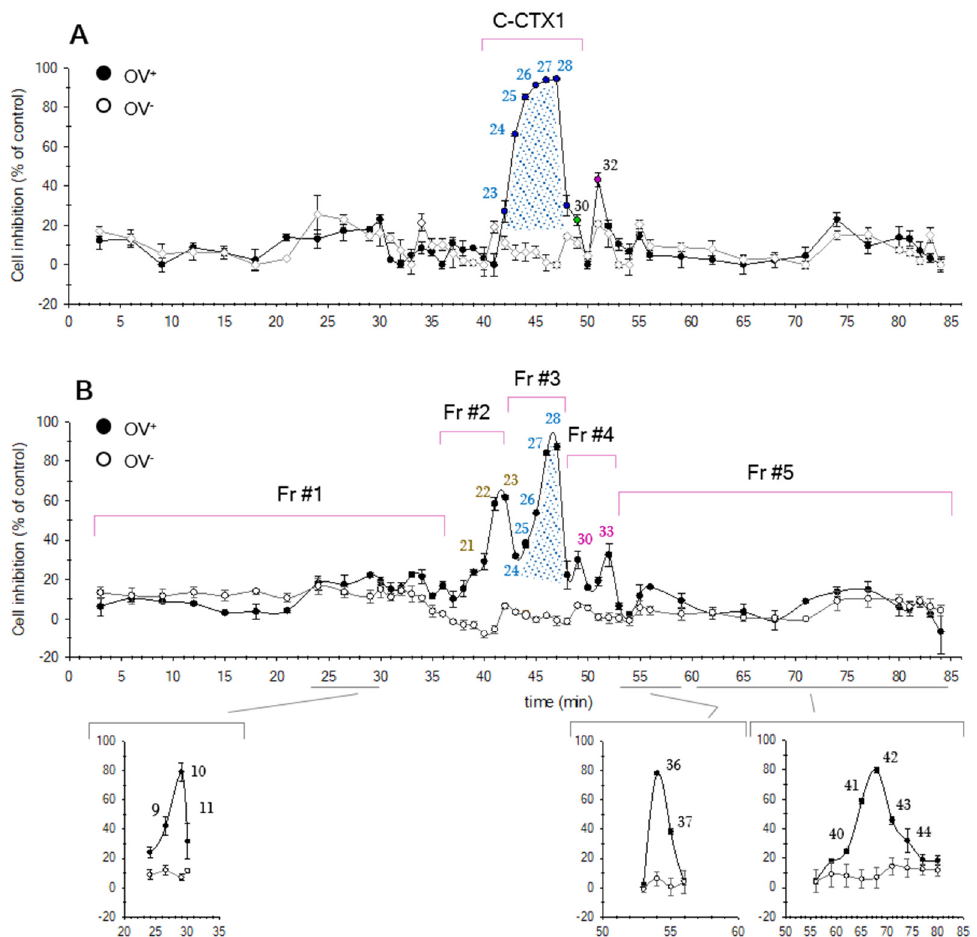
Figure 4. Example of the N2a toxicity profile after the HPLC fractionation of ( A ) Authentic C-CTX standard; ( B ) Naturally contaminated fish sample highlighting the main toxic regions. CTX-like compounds were collected in a total of five fractions: Fr #1, Fr #2, Fr #3, Fr #4, and Fr #5.